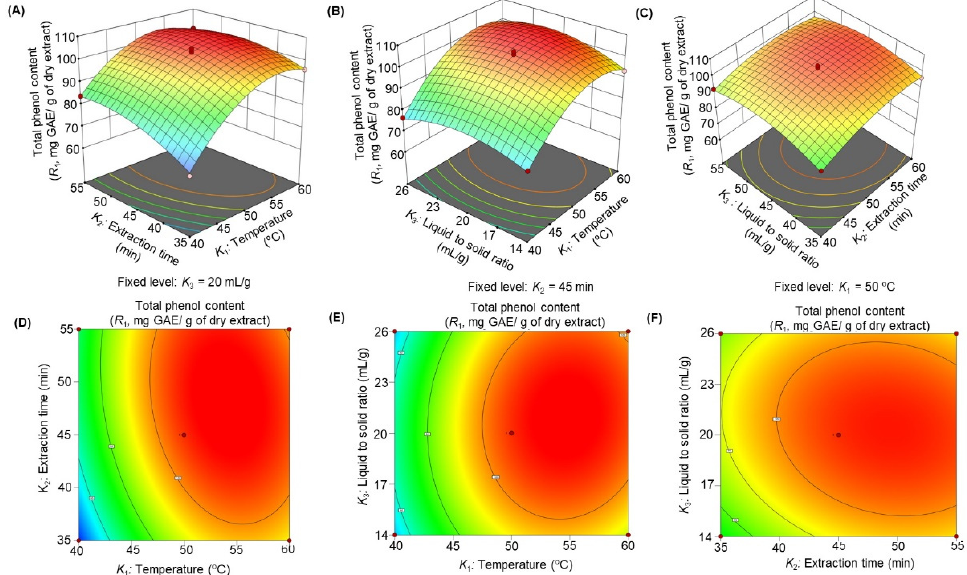
Figure 2. Response surface 3D and 2D contour plots showing the interaction effects of the UAE parameters on the TPC ( R 1 ). ( A ) 3-D response surface plots shows the effects of K 1 and K 2 interaction on TPC yield at constant K 3 (20 mL/g); ( B ) 3-D response surface plots shows the effects of K 1 and K 3 interaction on TPC yield at constant K 2 (45 min); ( C ) 3-D response surface plots shows the effects of K 2 and K 3 interaction on TPC yield at constant K 1 (50 °C); ( D ) 2-D contour plots shows the effects of K 1 and K 2 interaction on TPC yield at constant K 3 (20 mL/g); ( E ) 2-D contour plots shows the effects of K 1 and K 3 interaction on TPC yield at constant K 2 (45 min); ( F ) 2-D contour plots shows the effects of K 2 and K 3 interaction on TPC yield at constant K 1 (50 °C).